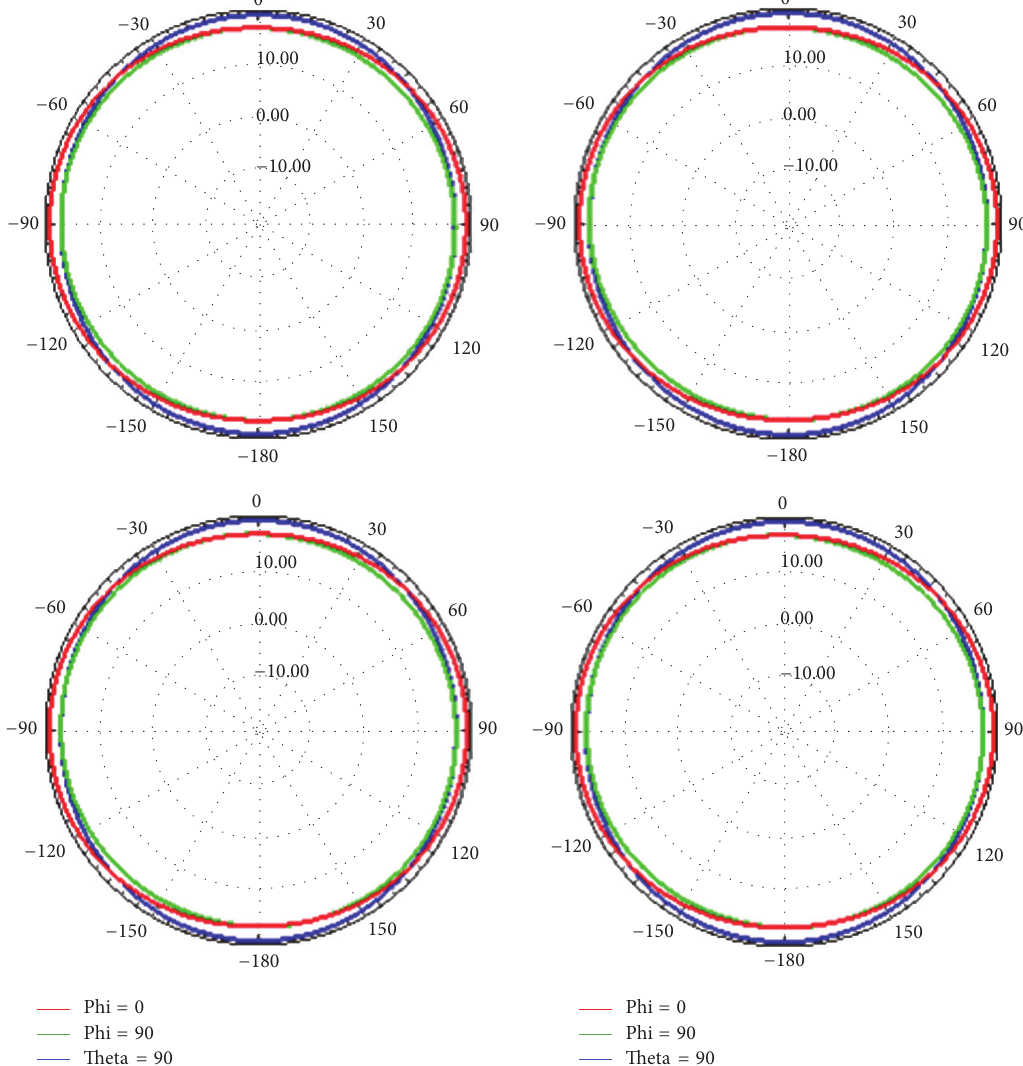
Figure 25: Radiation patterns ( 𝐸 total ) in 2D of each 3D spherical antenna (Table 9) in the plans: 𝑥𝑧 , 𝑦𝑧 , and 𝑥𝑦 .